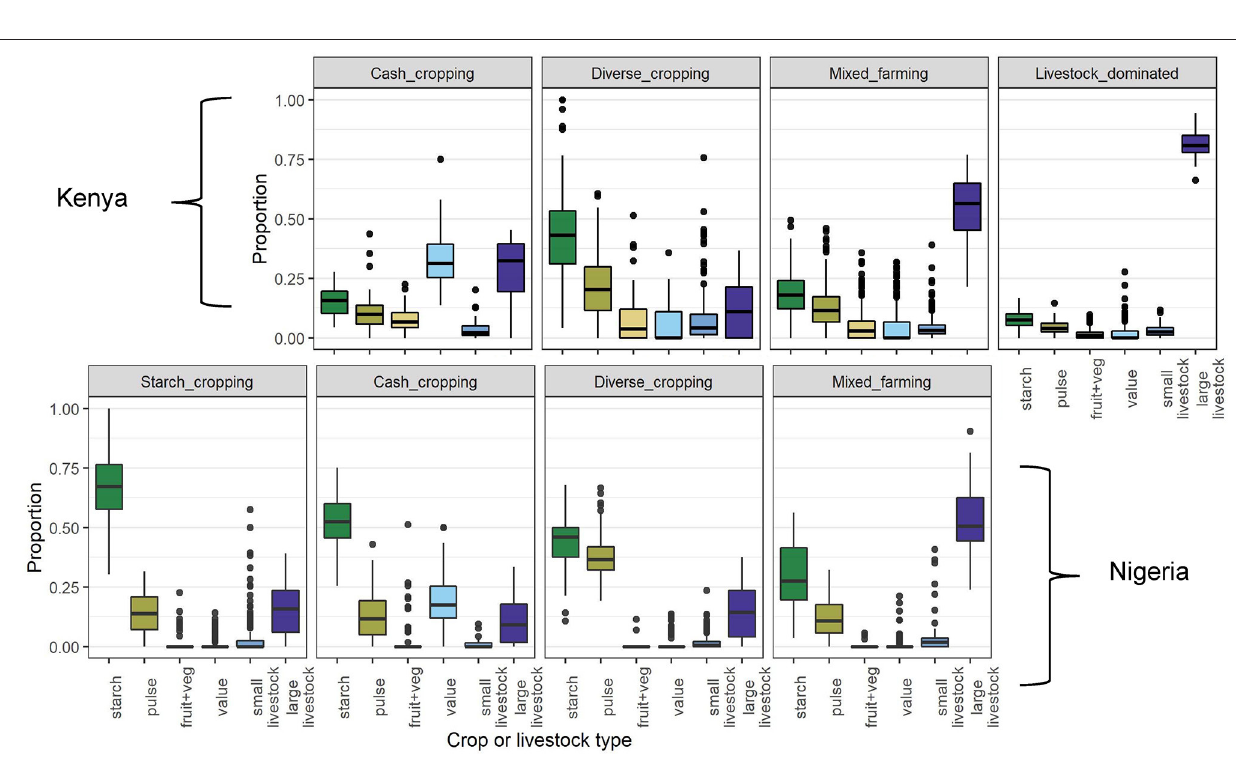
Frontiers in Sustainable Food Systems |